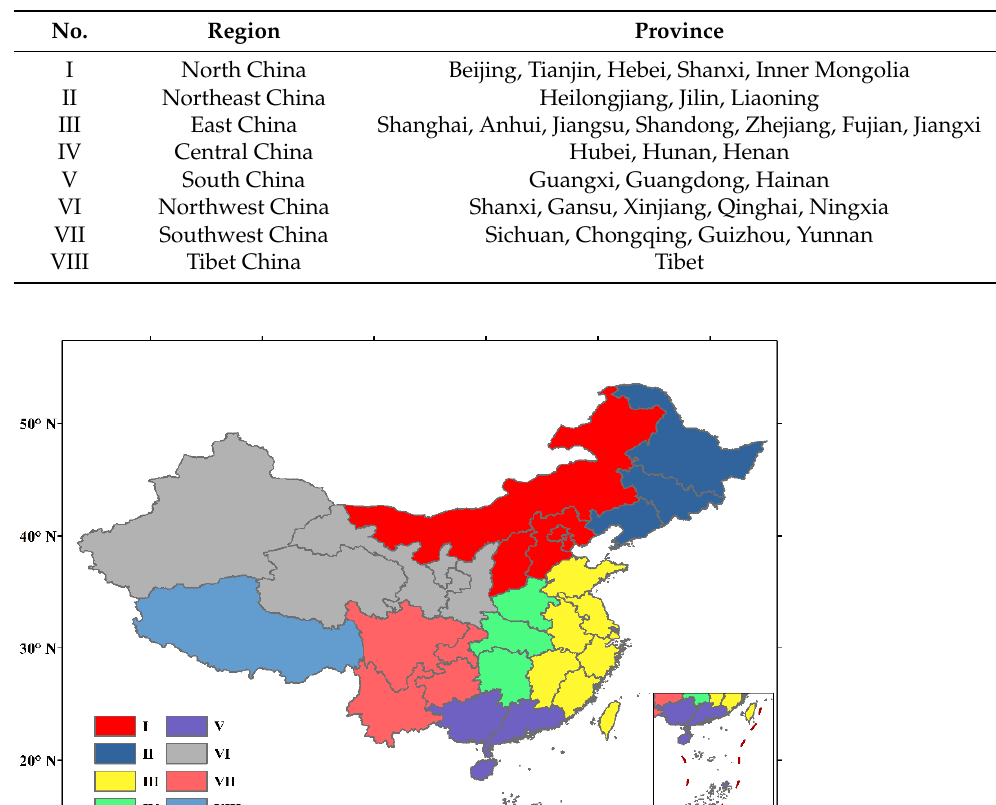
Table 1. Division of provinces by region.